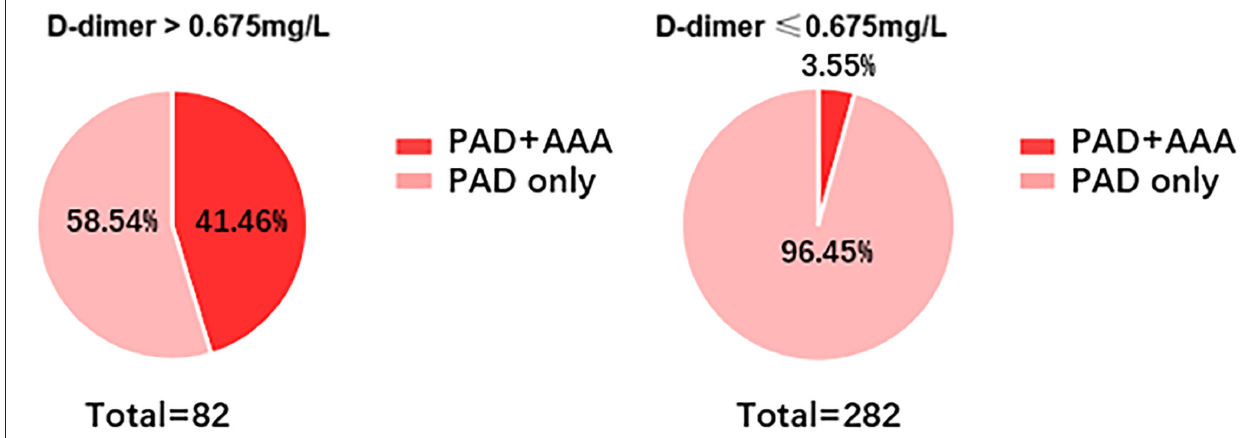
FIGURE 4 | Incidence of AAA in patients with PAD with different levels of D-dimer. Incidence of AAA was determined in patients with PAD when D-dimer is ≤ 0.675 mg/L or ≥ 0.675